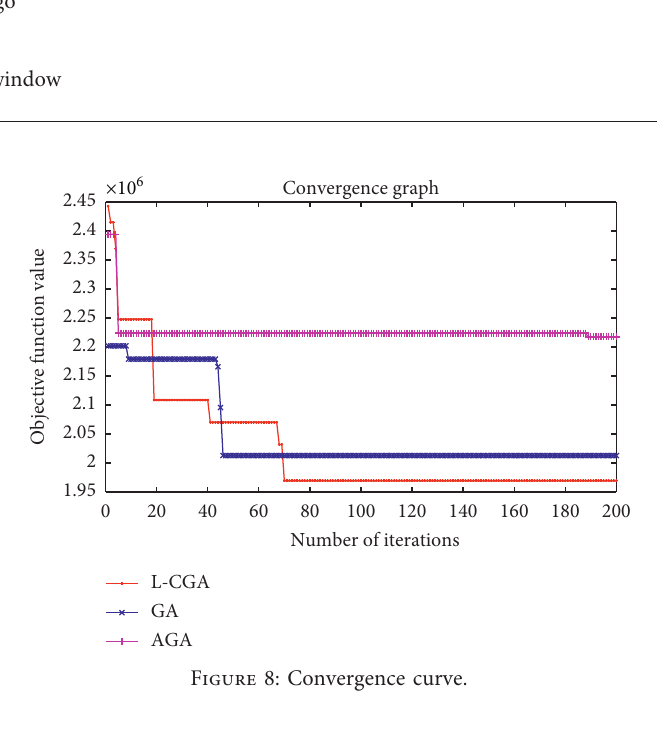
Figure 8: Convergence curve.